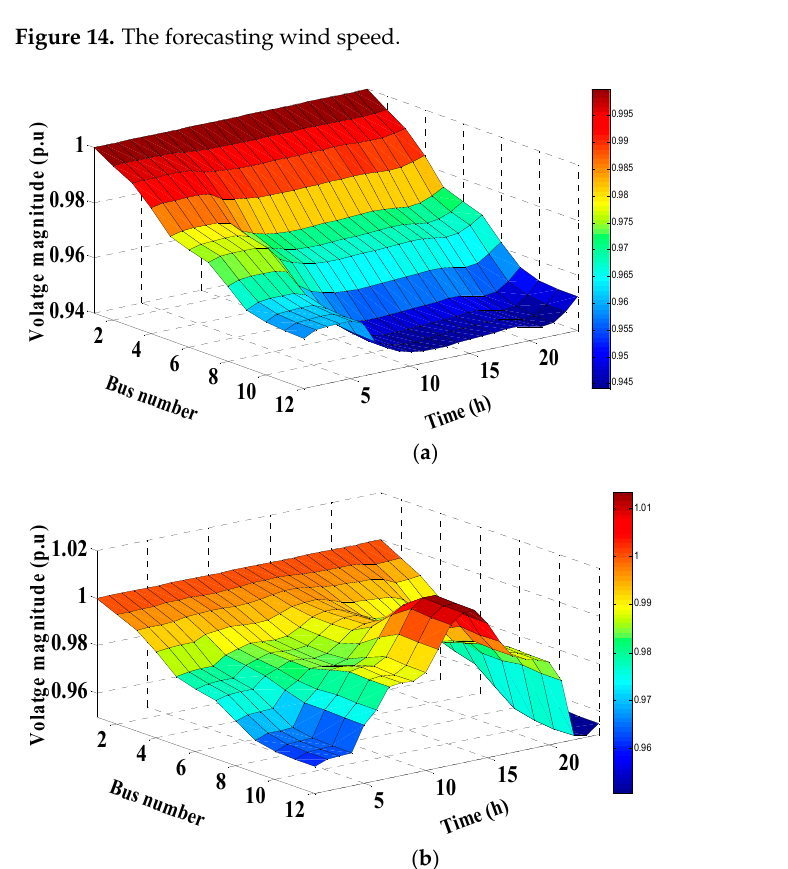
Figure 15. The voltage profile under probabilistic conditions ( a ) without RERs, ( b ) with RERs. Table 5. The simulation results of energy management of the MG under probabilistic conditions. Without RERs With RERs The energy losses (kWh) 1.45699 × 10 5 9.68580 × 10 4 The purchase energy from substa- tion (kWh)